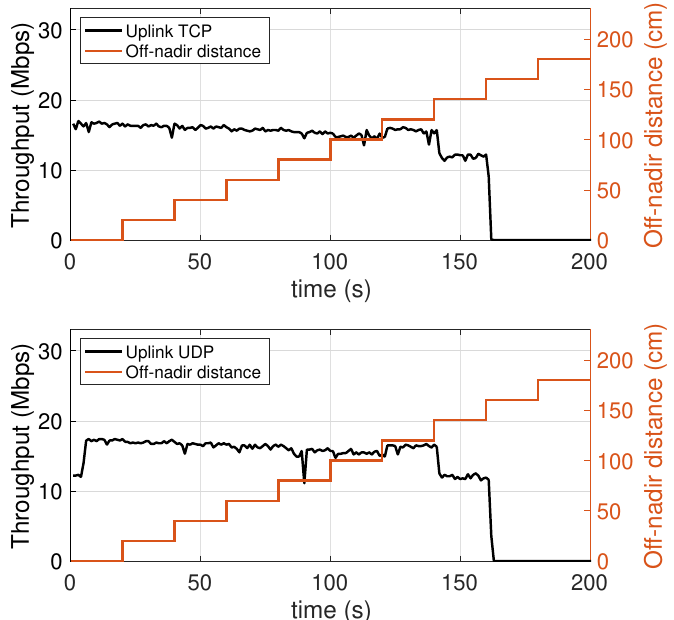
Figure 13. Uplink throughput with varying off-nadir distance of the mobile device. TCP (top chart) and UDP (bottom chart).